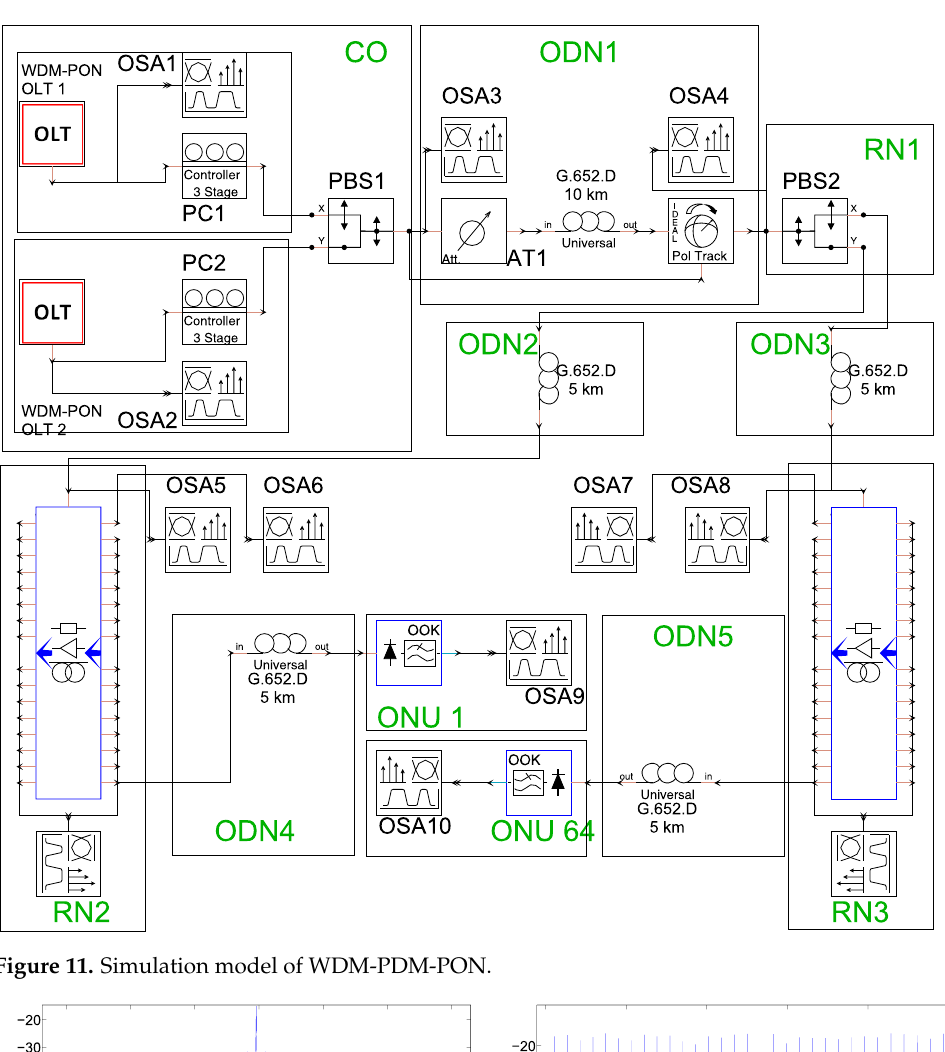
Figure 11. Simulation model of WDM-PDM-PON.